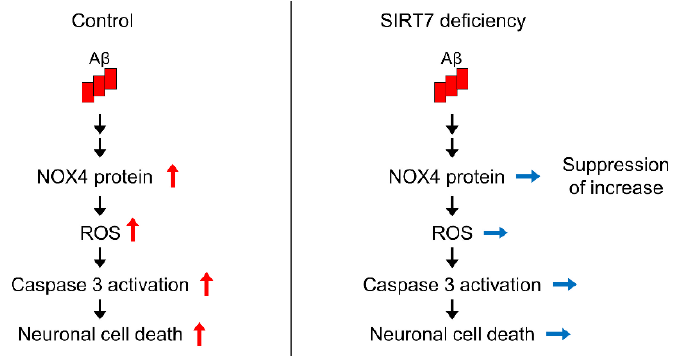
Figure 6. Proposed model of how SIRT7 deficiency protects against A β 42 -induced neuronal cell Figure 6. P roposed model of how SIRT7 deficiency protects against Aβ 42 -induced neuronal cell death.